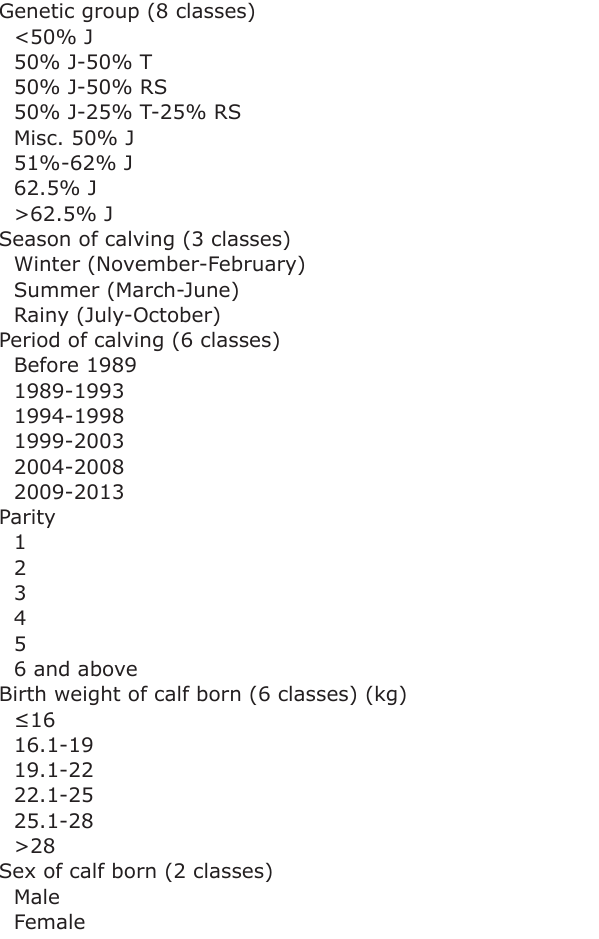
Table-1: Classification of data for genetic and environmental factors. Genetic group (8